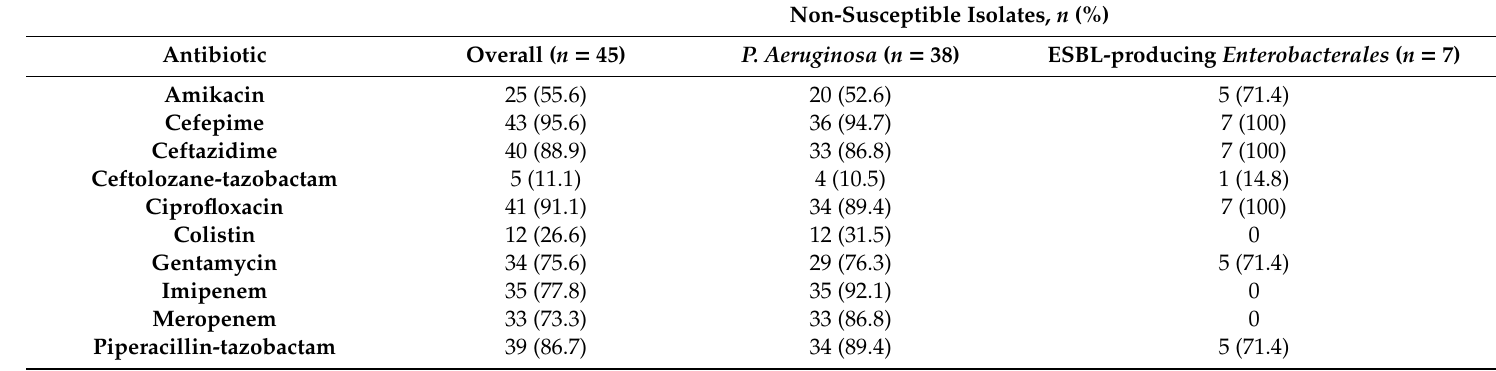
Table 3. Susceptibility test results of 45 non- Enterobacterales ( CRE) multidrug-resistant gram-negative bacteria (MDR-GNB) isolates from 41